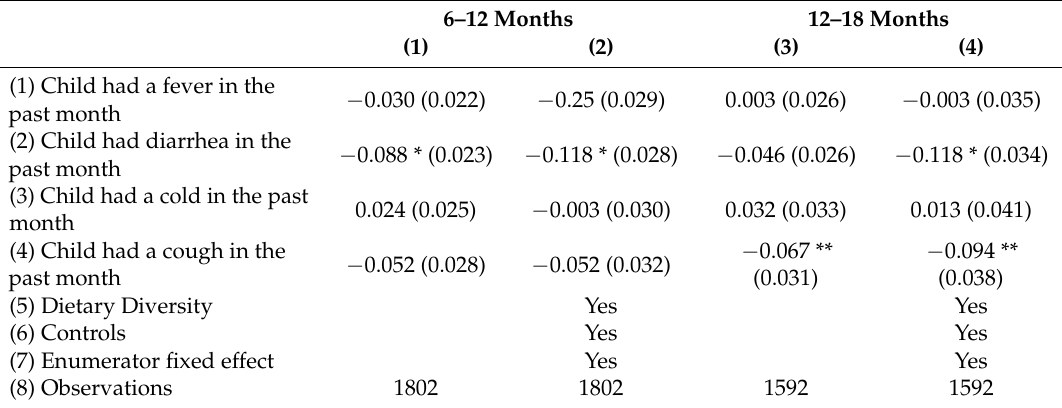
Table 6. Multivariate analysis: Correlations between breastfeeding and health outcomes in infants aged 6–18 months in rural